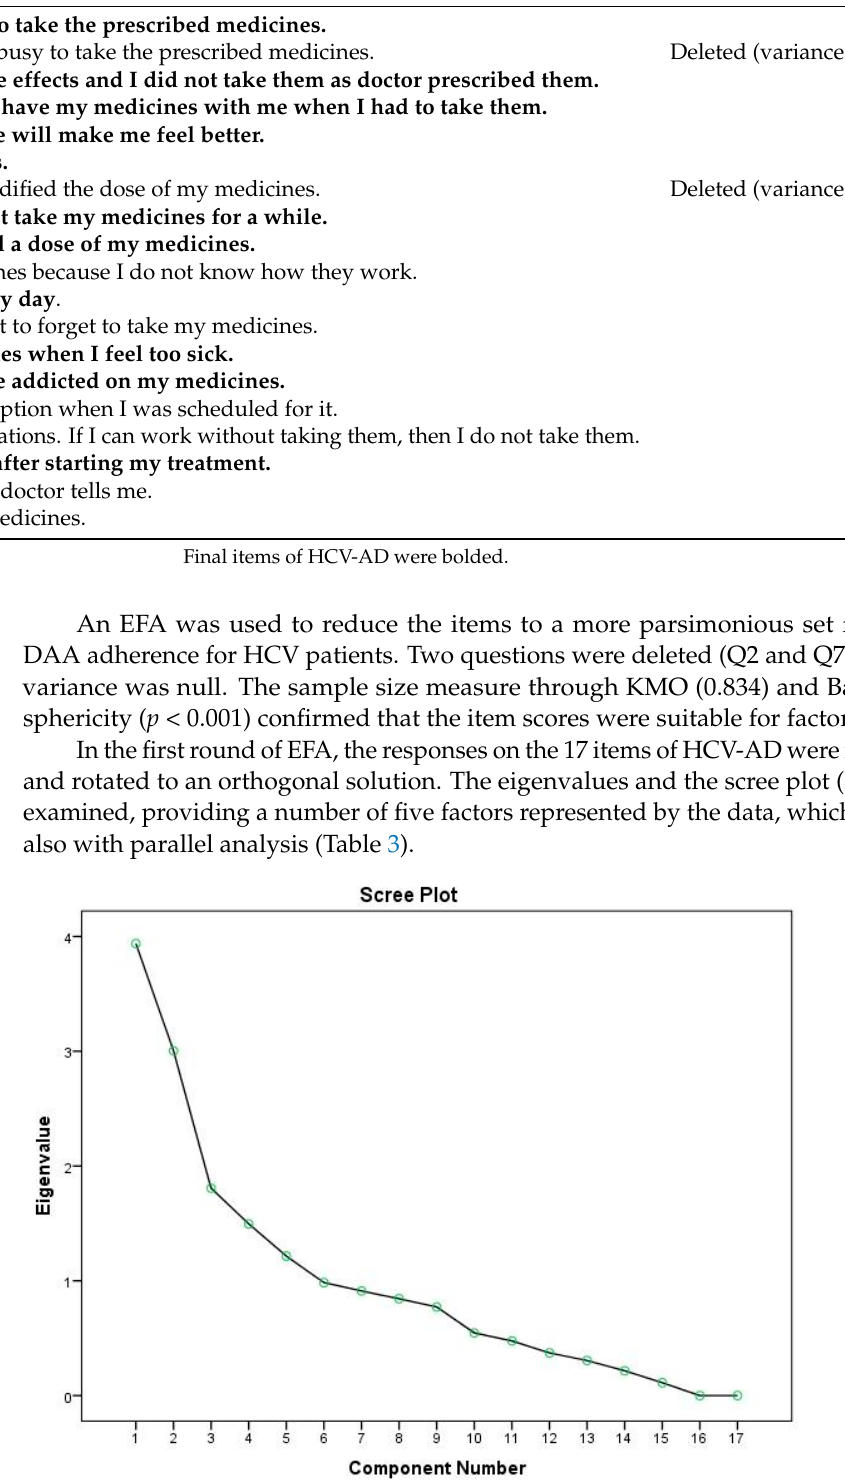
Figure 2. Scree plot of Exploratory Factor Analysis.